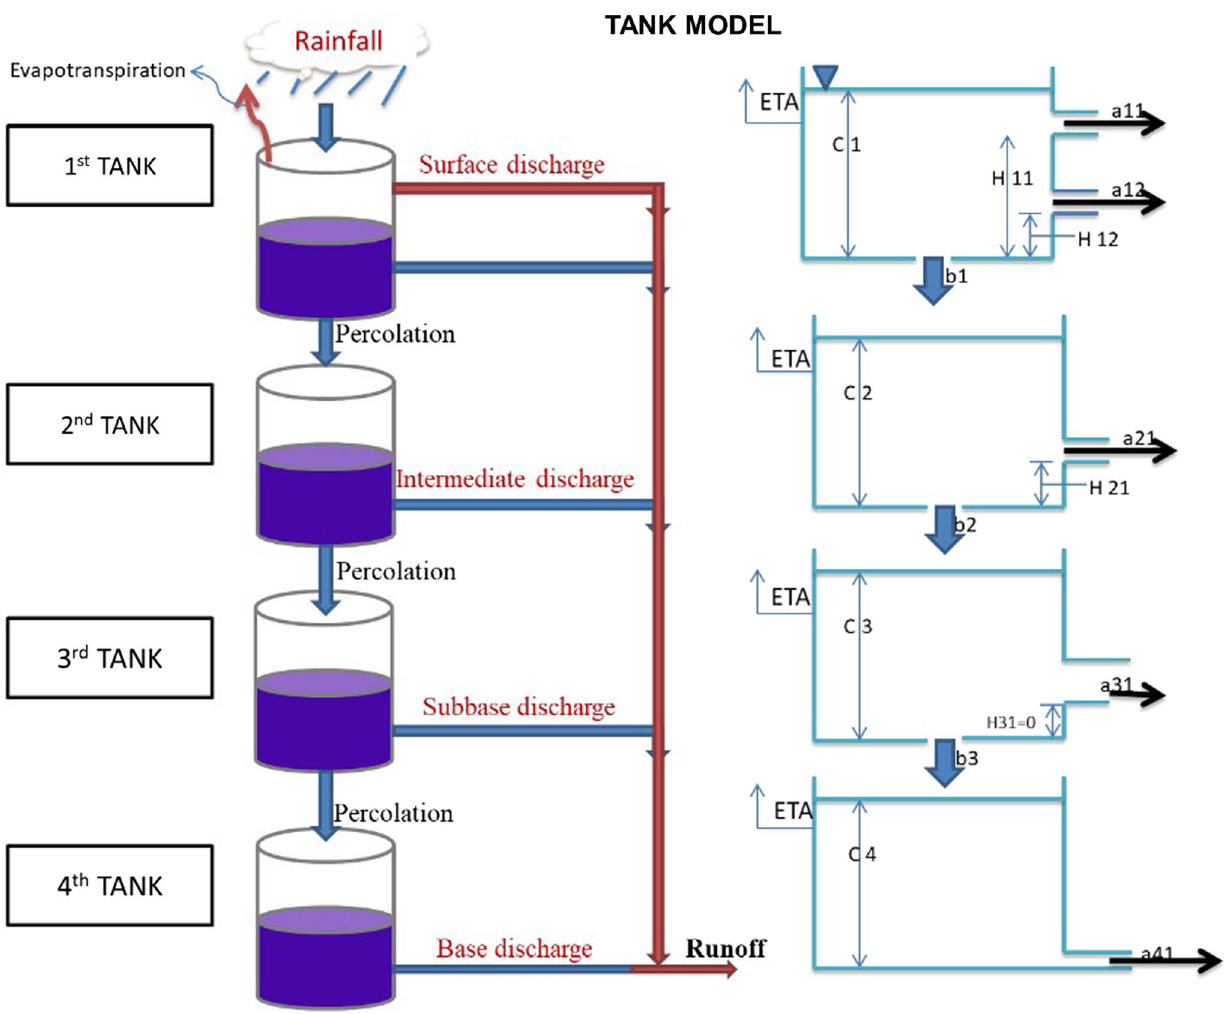
Fig. 2 Structure of TANK Model in RRL. (Reproduced from RRL